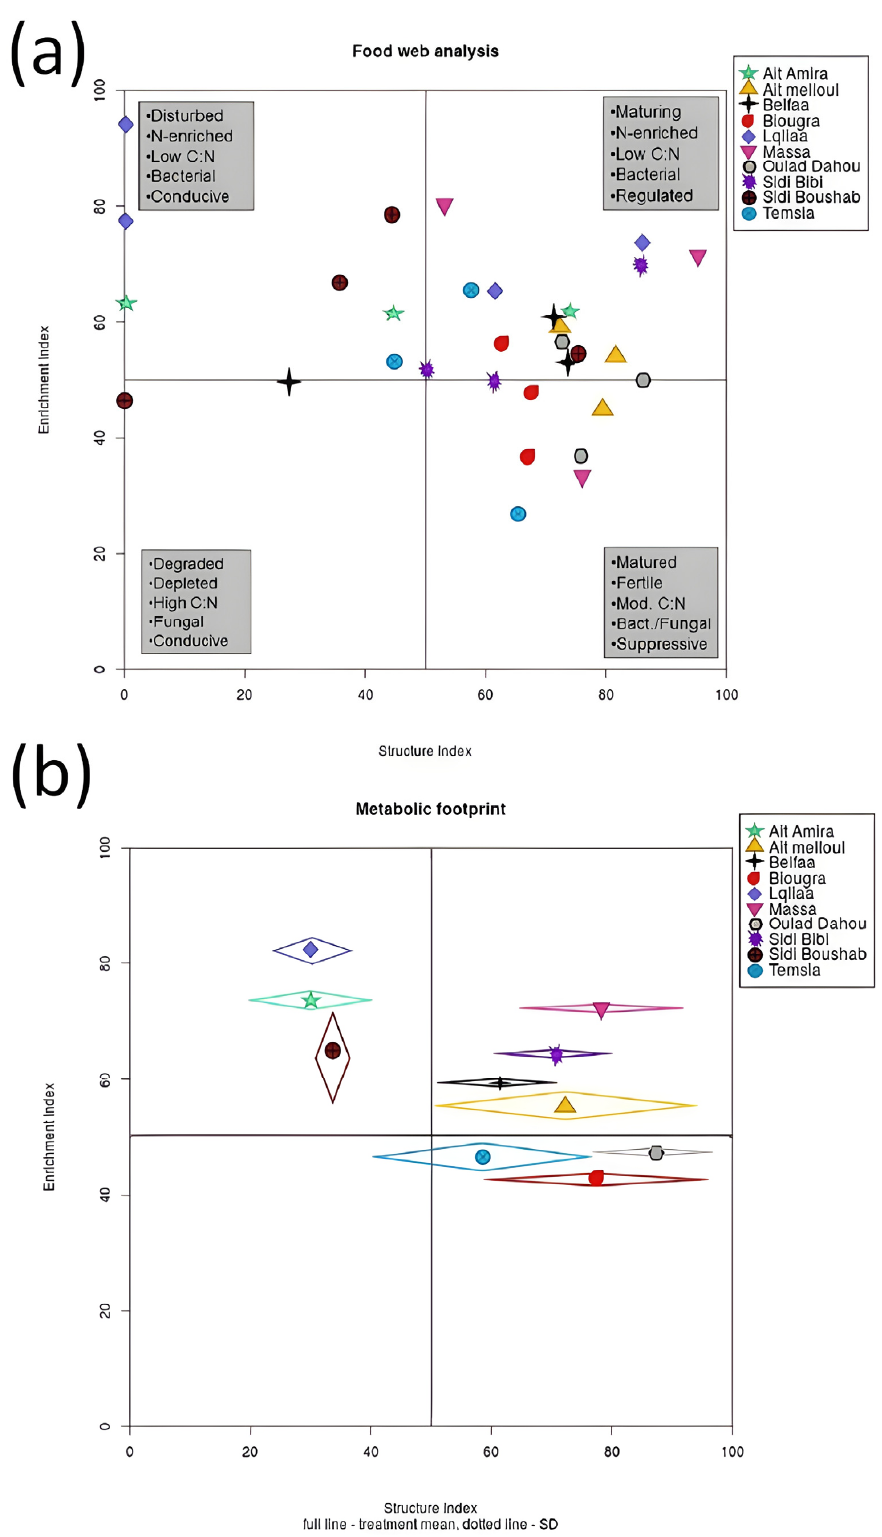
Figure 7. Nematode food web diagnostics and their position as soil health bioindicators. ( a ) Food web analysis of nematode communities at different wheat areas sampled. ( b ) Metabolic footprint showing the amplitudes of nematode enrichment and structure indices throughout wheat areas sur- veyed.